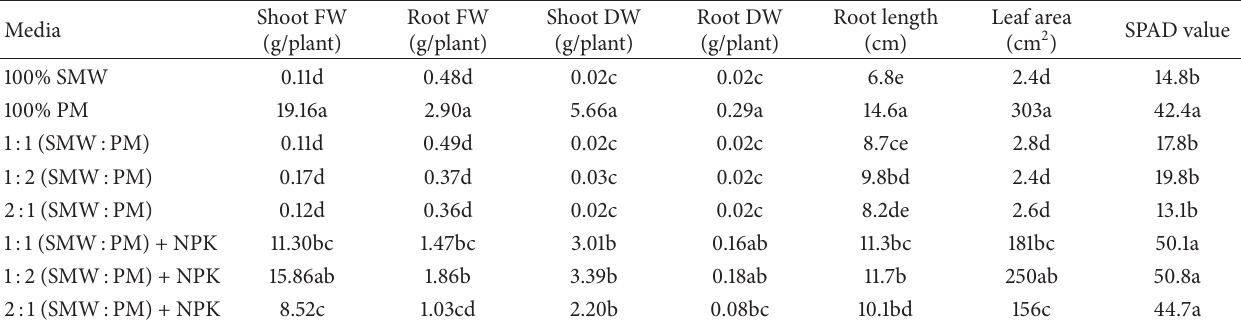
Table 3: Different growth parameters of Kai-lan as influenced by planting media at harvest (5 weeks after transplanting). Shoot FW Root FW Shoot DW Root DW Root length Leaf area SPAD value Media (g/plant) (g/plant) (g/plant) (g/plant) (cm) (cm 2 ) 100% SMW 0.11d 0.48d 0.02c 0.02c 100% PM